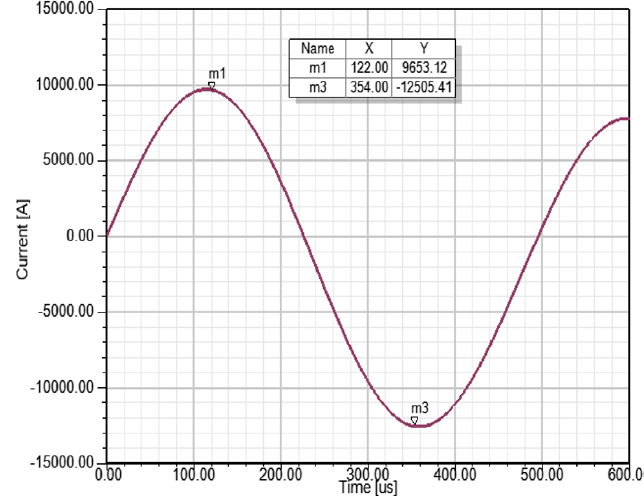
Figure 7. The secondary side current waveform with the oil tank.